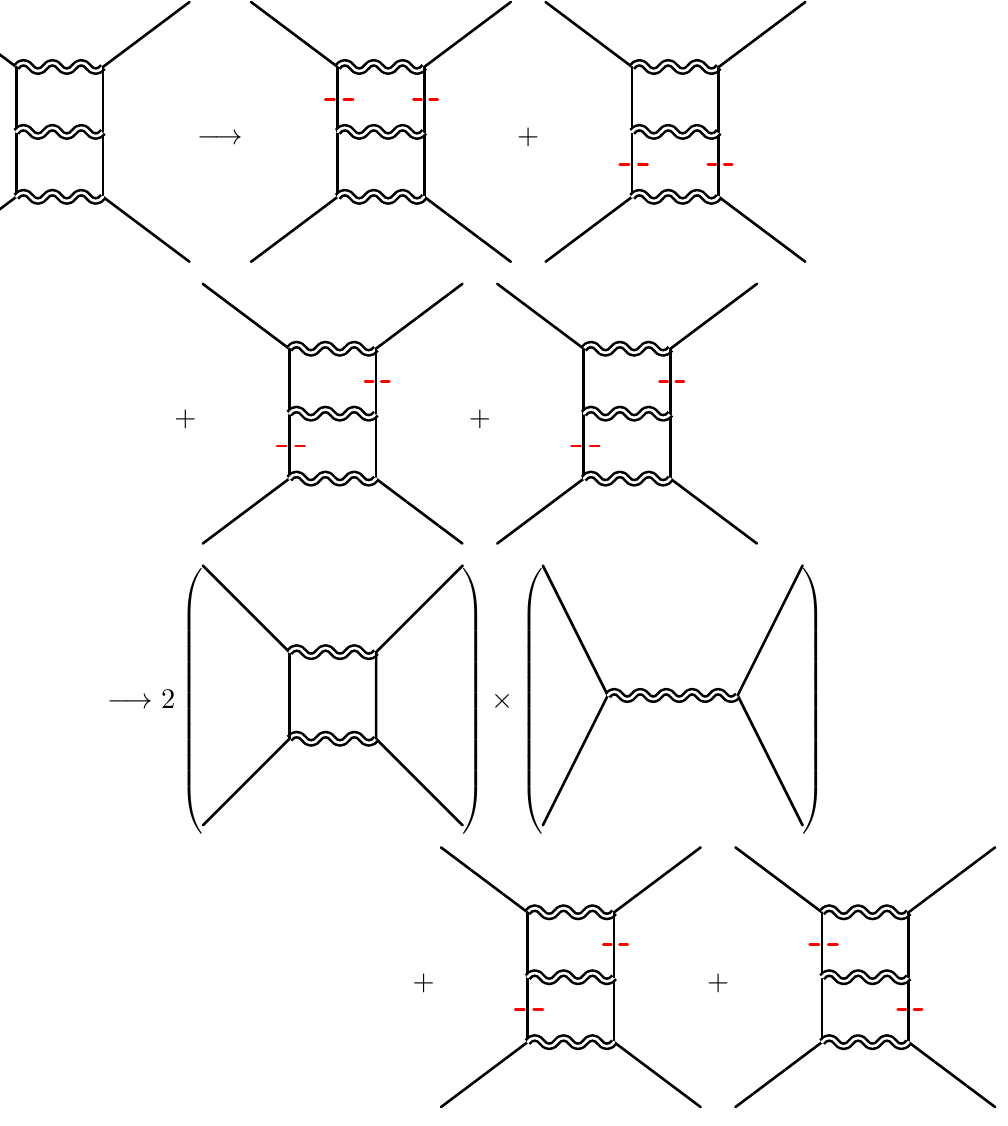
Figure 8 . Velocity cuts of the double-box